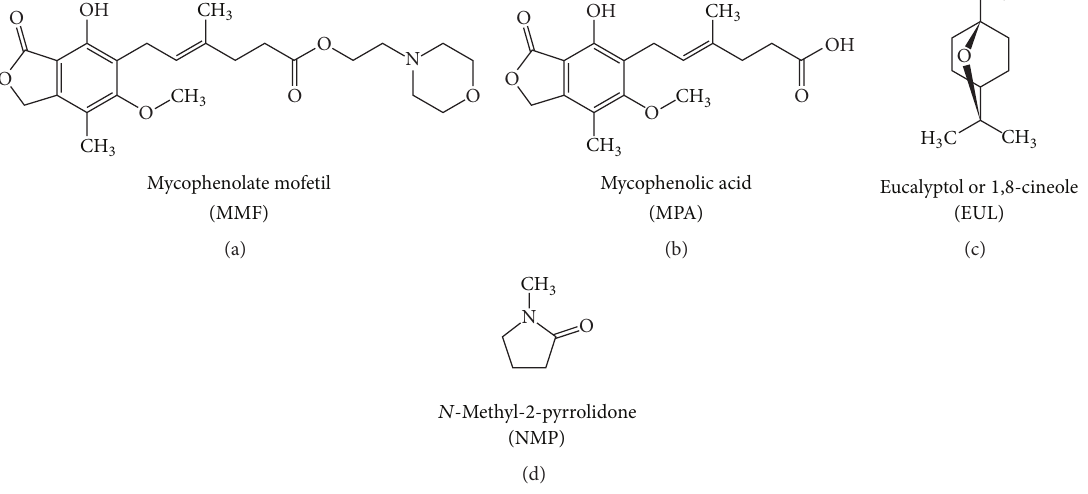
Figure 1: Chemical structure of MMF (a), MPA (b), EUL (c), and NMP